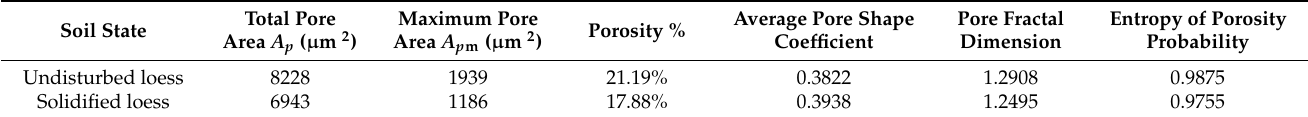
Table 5. Statistical parameters of soil